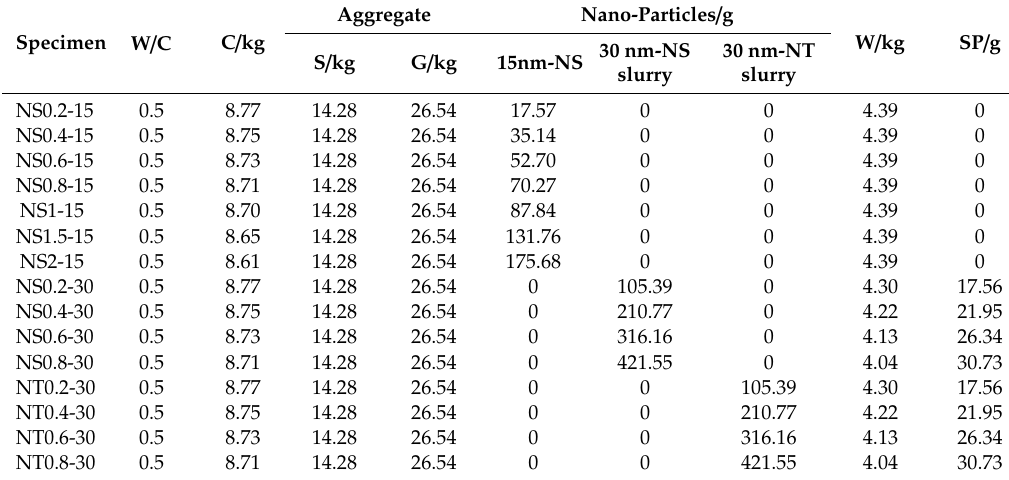
Table 5. The mix proportions of